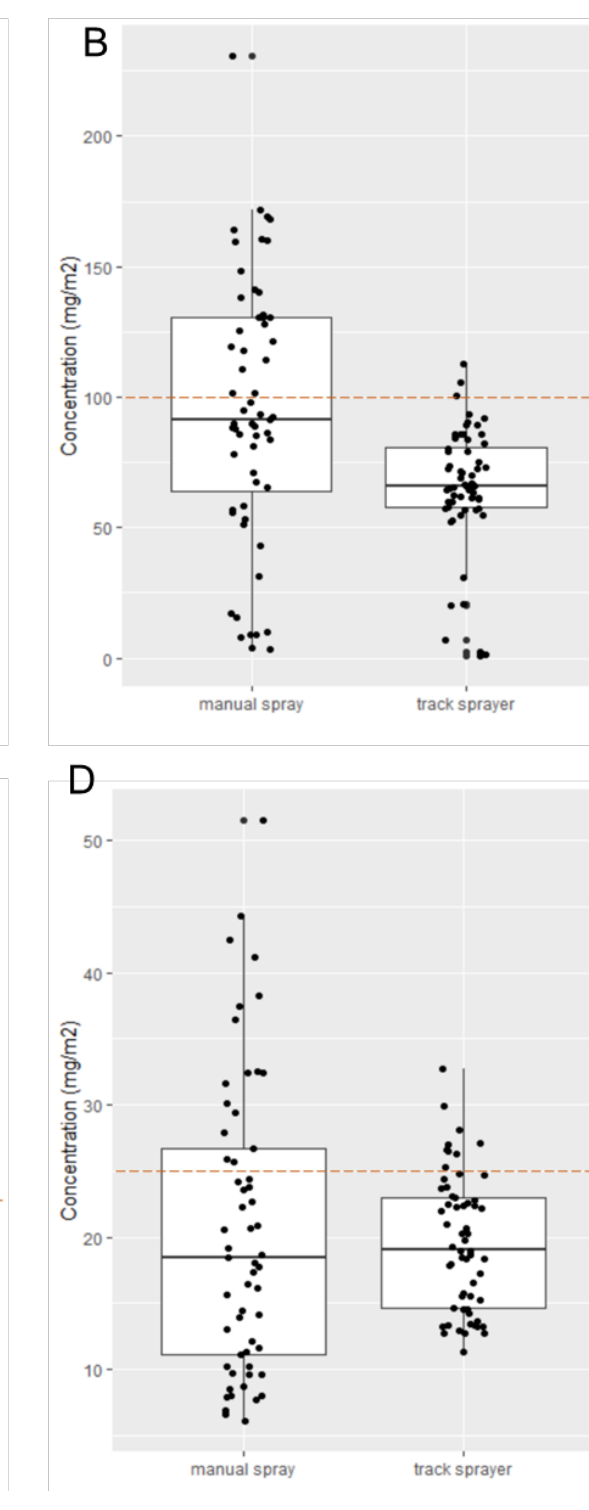
Figure 3. Concentration of active ingredient on filter papers sprayed by manual spraying or the automated track sprayer. Filter papers were attached to plywood panels in a grid of 15 per swath. Four swaths were treated for each spray method per insecticide, resulting in 120 filter papers per insecticide. Letters A–D indicate the active ingredients; pirimiphos-methyl ( A ), broflanilide ( B ), clothianidin ( C ), and deltamethrin ( D ). Individual dots show the values for each filter paper. Boxplots indicate median, 25th and 75th percentile, extreme lines, and potential outliers. Dashed horizontal lines represent the target concentration for each